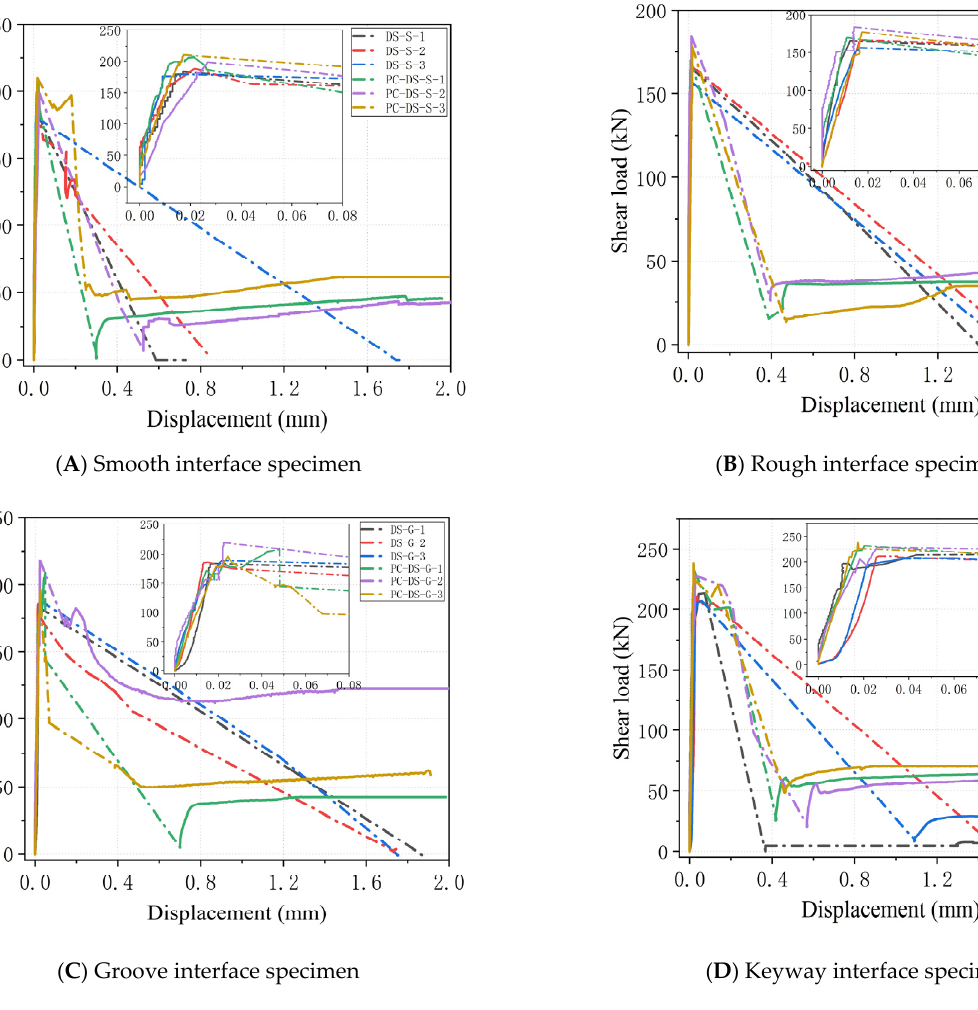
Figure 6. Load-displacement curves of different interfaces under unconstrained and passive con- straints.